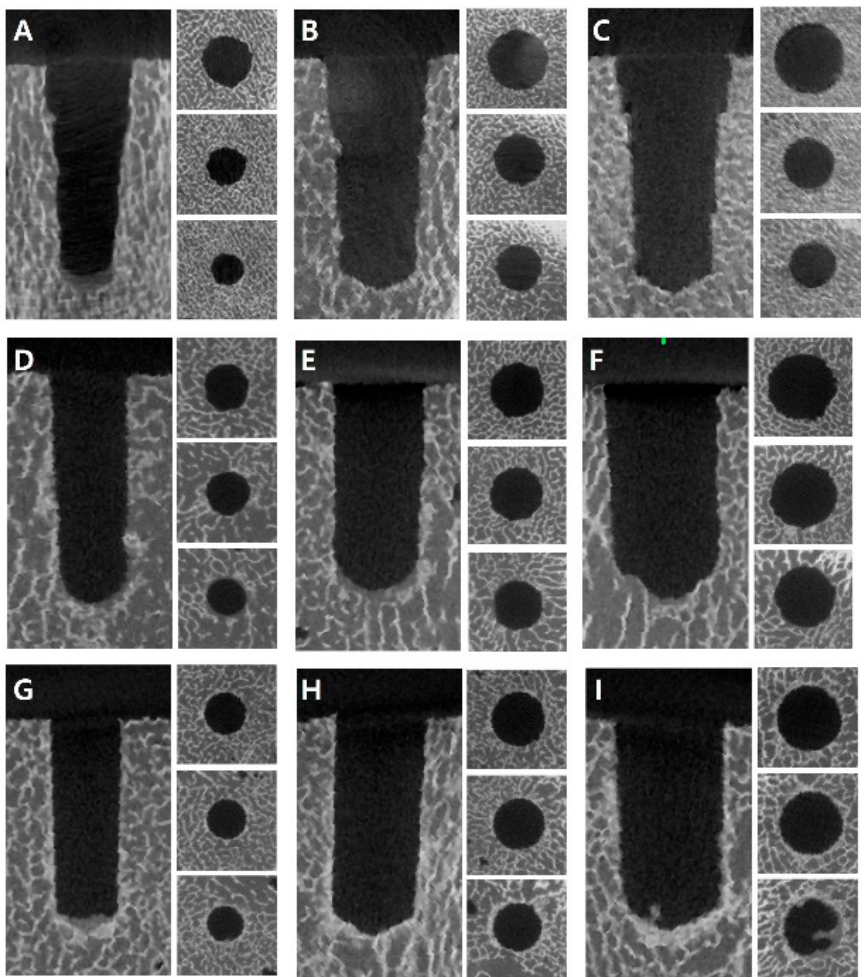
Figure 6. Comparison of bone density around the drilling holes on micro-positron emission tomography/computed tomography images according to diameters and techniques: ( A ) conventional technique (CD) with 3.8 mm drilling; ( B ) CD with 4.8 mm drilling; ( C ) CD with 5.8 mm drilling; ( D ) osseodensification technique in the clockwise direction (OD-C) with 3.5 mm drilling; ( E ) OD-C with 4.5 mm drilling; ( F ) OD-C with 5.5 mm drilling; ( G ) osseodensification technique in the counter-clockwise direction (OD-CC) with 3.5 mm drilling; ( H ) OD-CC with 4.5 mm drilling; ( I ) OD-CC with 5.5 mm drilling.